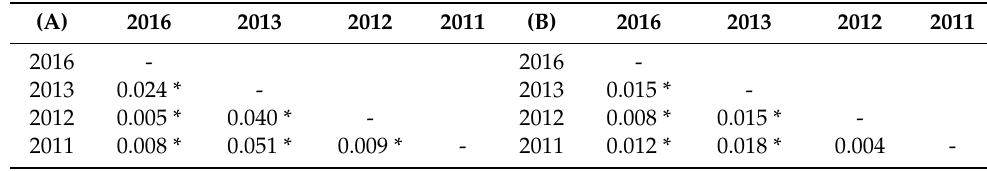
Table 7. Assessment of the genetic di ff erentiation by the year of sampling in M. persicae aphids. The fixation index Fst was computed using ( A ) all clonal copies per multilocus genotype or ( B ) one single